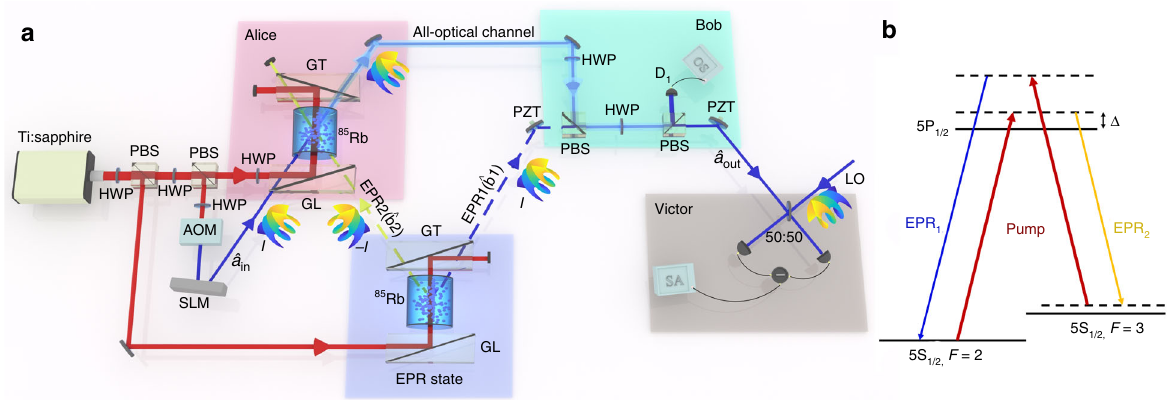
j i , EPR state input state populated by a coherent state α in in retrieved state, D 1 photodetector, OS out